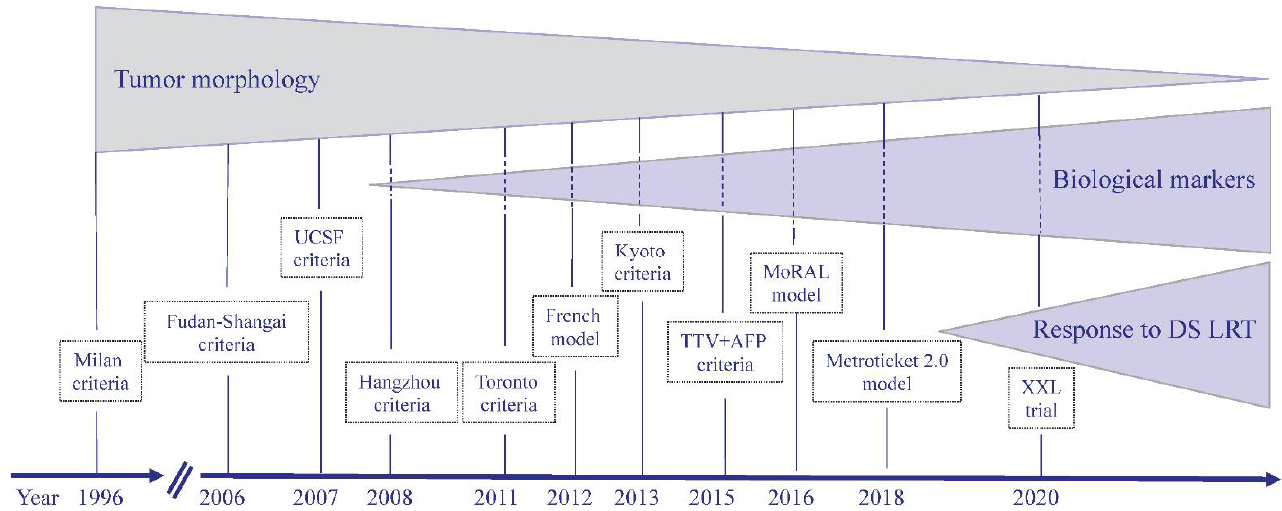
Figure 1. Evolving concepts in the selection of patients with HCC for liver transplantation. After the discovery of the Milan criteria in 1996, the subsequently expanded criteria for liver transplantation in patients with HCC were mainly based on the morphological characteristics of the tumor. Starting in 2008, with the Hangzhou criteria, the addition of biological markers to tumor morphologic criteria allowed expansion of the original Milan criteria, maintaining a good clinical outcome of liver transplanted patients with HCC. More recently, the new way to select patients to be transplanted for HCC who are beyond the Milan criteria at presentation has been to qualify those who can be traced back to the Milan criteria after successful downstaging after locoregional and/or systemic treatments. UCSF: University California, San Francisco; TTV: total